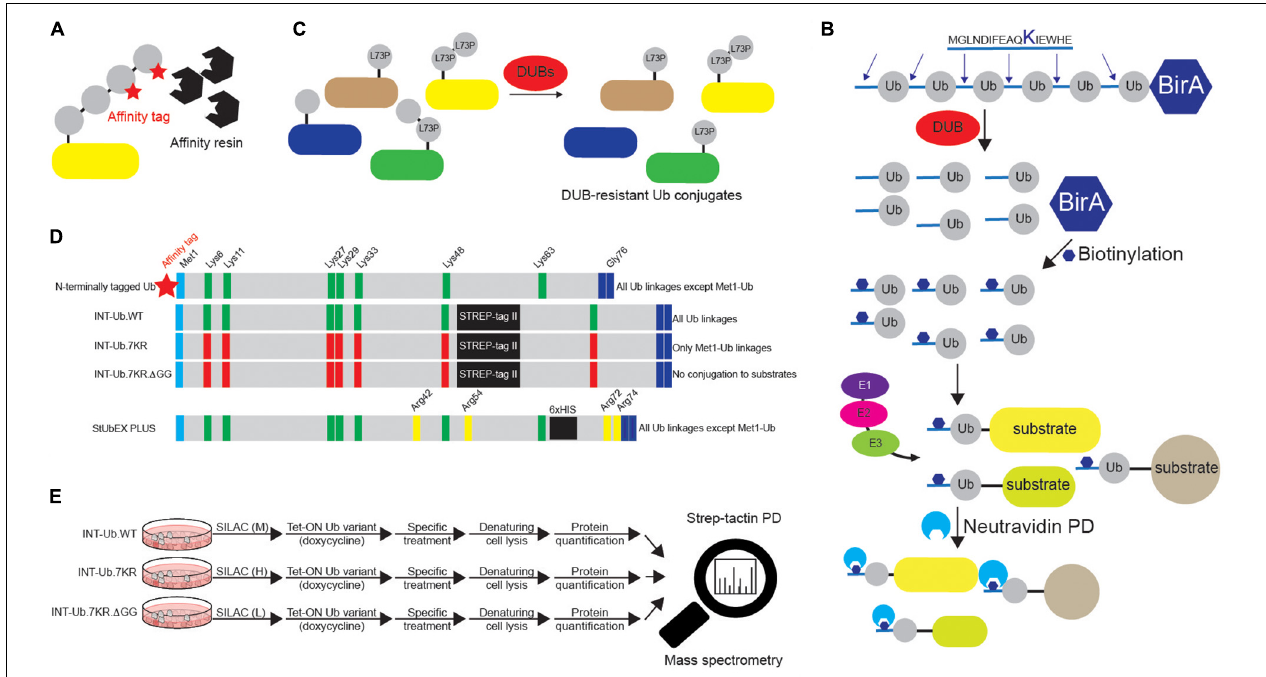
FIGURE 5 | Various approaches to study ubiquitination targets. (A) Various N-terminally tagged Ub variants can be exogenously added to cells to enable affinity purifications of ubiquitinated substrates upon denaturing lysis. Short and relatively linear tags (such as 6xHIS, STREP, HA and FLAG), combined with their respective affinity resins (Ni-NTA, strep-tactin, HA agarose and FLAG agarose) are often used in such experiments. Besides N-terminally tagged wild-type Ub, additional Ub variants are often used, such as specific Lys mutants (single or multiple Lys6, Lys11, Lys27, Lys29, Lys33, Lys48 and Lys63 residues mutated to either Arg or Ala). Additionally, residues relevant for Ub binding properties, such as Ile44 and Ile36, can also be mutated to either Arg or Ala. (B) Dual BirA system contains synthetic hexaUb sequence fused C-terminally to E. coli BirA gene (Ub 6 -BirA). Each Ub in the construct contains 16 amino acids sequence at the N terminus that can be biotinylated by BirA. Once expressed in cells (or organisms), linear hexaUb is processed by cellular DUBs and undergoes biotinylation by BirA. When used by cellular ubiquitination machinery, biotin-containing Ub conjugates can be efficiently affinity purified with neutravidin resins and subsequently analyzed by Western blot and mass spectrometry. Due to the N-terminal tagging of Ub, such approach cannot be used to enrich linear ubiquitination targets. (C) DUB-resistant Ub variant Leu73Pro increases the half-life and stability of the formed Ub linkages and facilitates their subsequent identification. (D) Two MS-coupled approaches rely on the use of internally tagged Ub variants. Unlike N-terminally tagged Ub, INT-Ub and INT-Ub.7KR variants enable affinity purification of ubiquitinated proteins and Met1-Ub-modified substrates, respectively, due to the existence of internal affinity purification STREP-tag between Ub residues Lys48 and Lys63 that keeps Ub Met1 free to interact with Gly76 of another Ub molecule. (E) INT-Ub approach is based on inducible expression of INT-Ub variants in SILAC-treated cells, followed by denaturing lysis, strep-tactin pull-down and subsequent MS analysis. The presence of the internal tag does not affect the overall behavior of Ub. Similar to